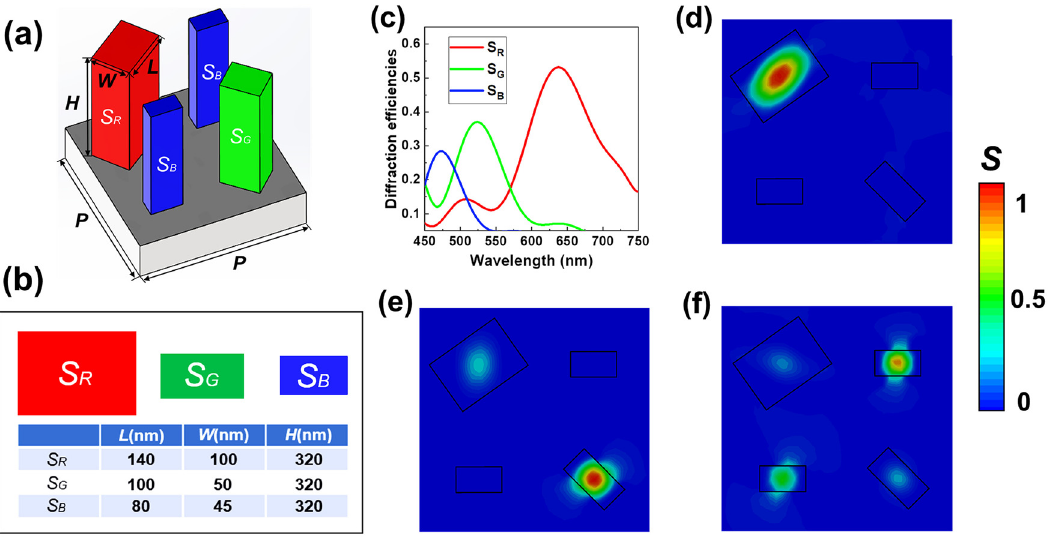
Figure 4: Illustration of the supercell. (a) One supercell composed of three kind of Si nanoblocks (b) Three Si nanoblocks with different dimension. (c) Simulated transmission spectra of an individual nanoblock of S R , S G and S B . (d – f) Top views of the optical energy distributions with the different wavelengths of R, G and B.